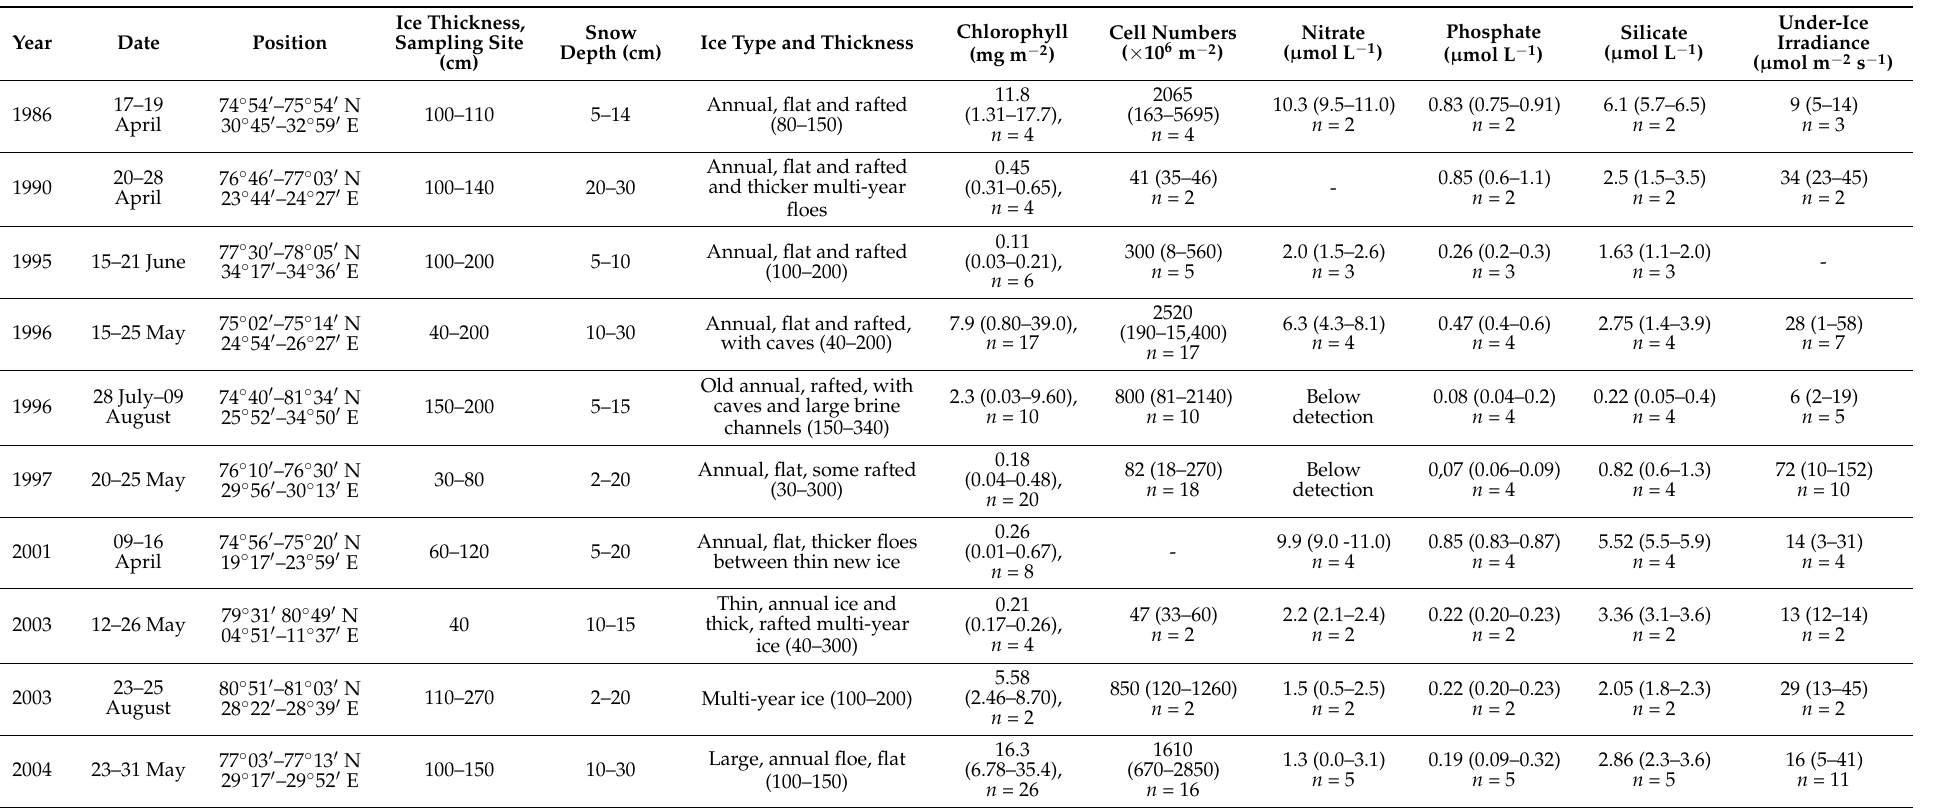
Table 1. Positions and dates for the various cruises in the Barents Sea 1986–2004. Ice type describes ice in the sampling area, while ice thickness (cm) and snow depth (cm) are determined from sampling sites. Under-ice irradiance ( µ mol m − 2 s − 1 ), chlorophyll (mg m − 2 ), and cell numbers ( × 10 6 m − 2 ) are given as average and range (in brackets), the same for the nutrient concentrations (nitrate, phosphate, and silicate, µ mol L − 1 ) from surface waters at sampling